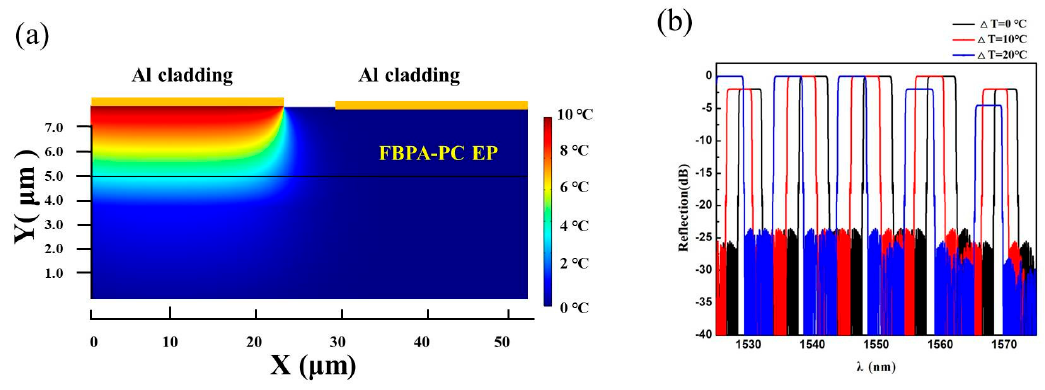
Figure 9. ( a ) Cross-sectional thermal field distribution of the metal-printing heater. ( b ) Simulated reflection spectrum of proposed sampled grating when Δ T = 0 °C, 10 °C and 20 °C, respectively.